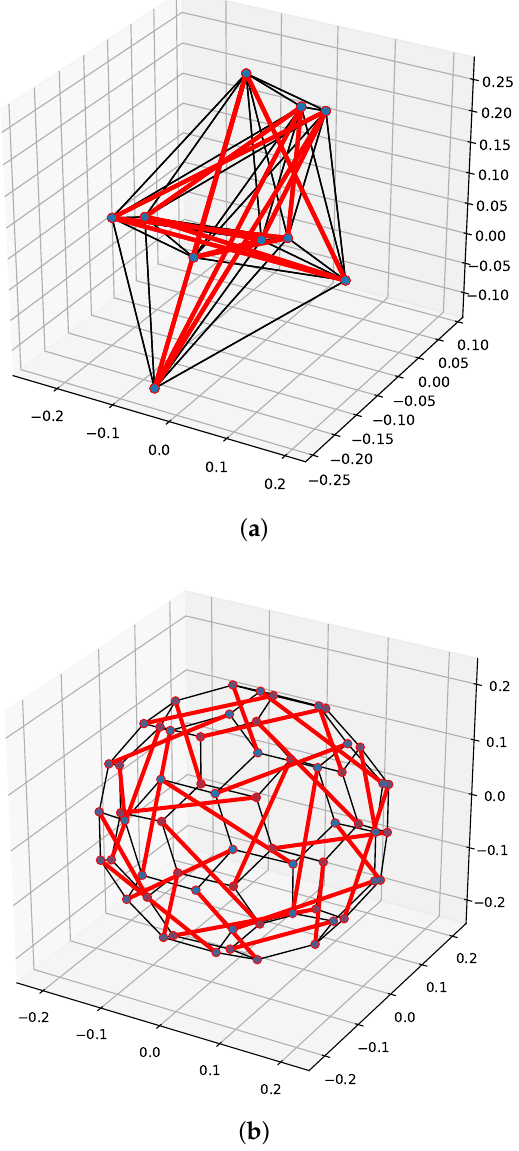
Figure 26. Final geometry of eight iterations of the 3D-truncated icosahedron tensegrity module using an FDM and a DNN-based form-finding model with DE algorithm. ( a ) FDM. ( b ) DNN-based form-finding